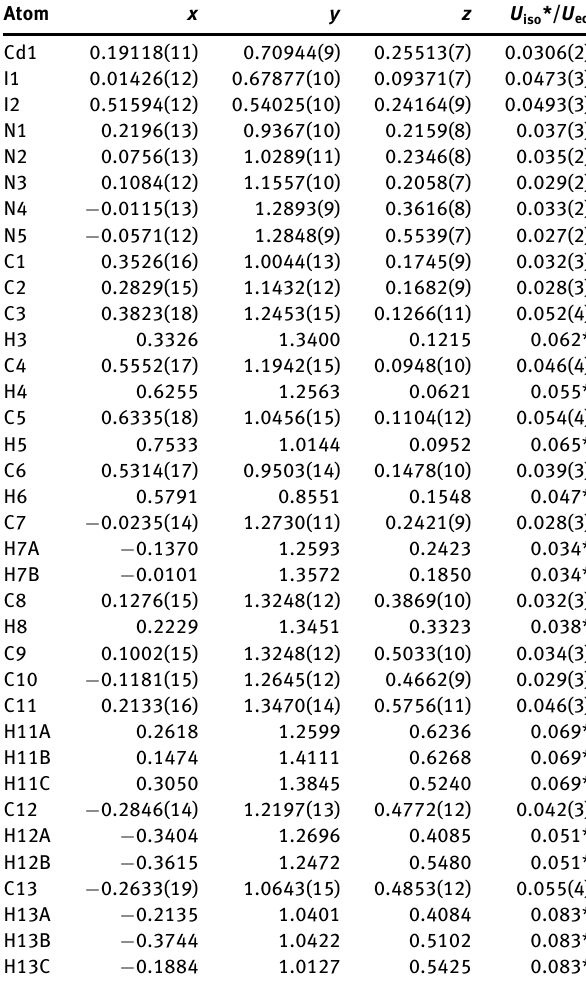
Table 2: Fractional atomic coordinates and isotropic or equivalent isotropic displacement parameters (Å 2